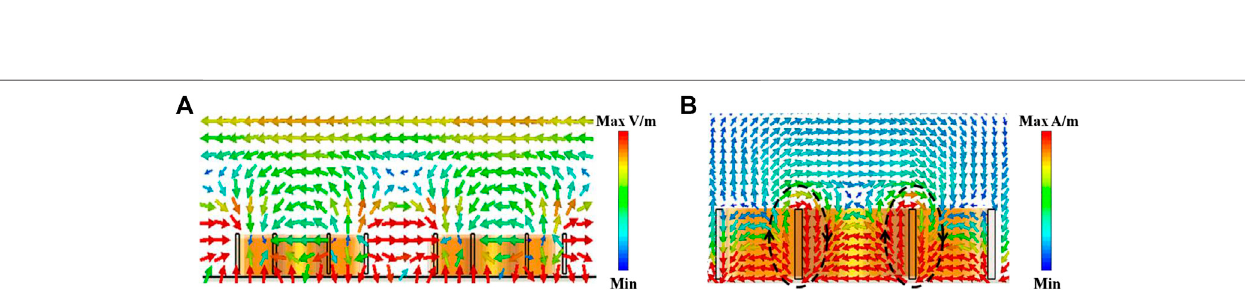
Frontiers in Physics |